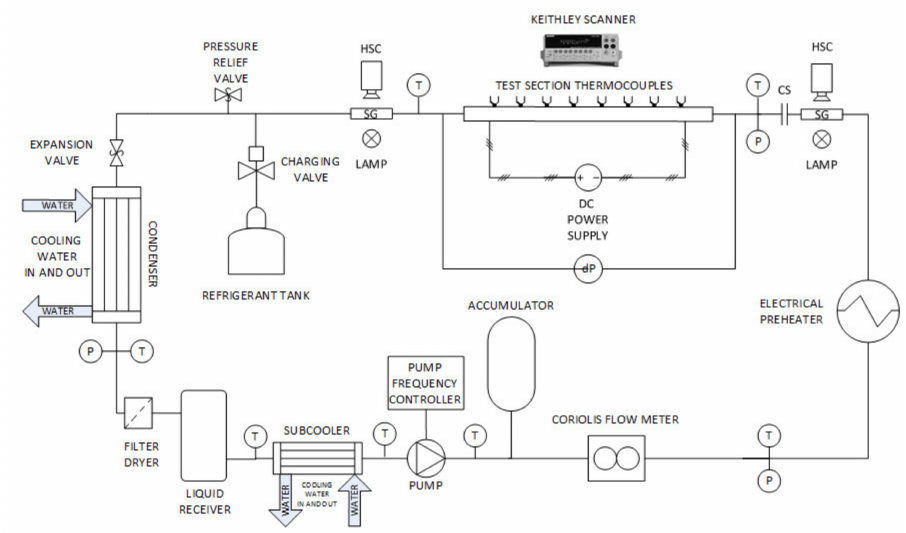
Figure 3. Experimental test